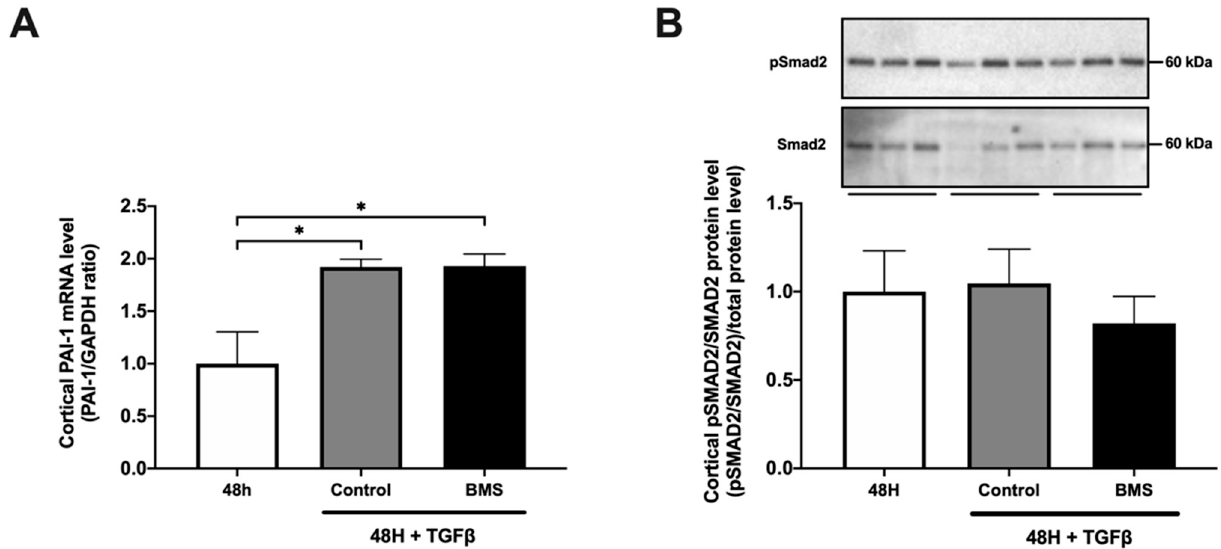
Figure 2. BMS-986205 does not alter canonical TGF- β signaling in murine PCKS. PCKS were exposed to 10 ng/mL TGF- β in the absence or presence of BMS-986205 (5 nM) for 48 h. ( A ) Relative mRNA expression of plasminogen activator inhibitor-1 (PAI-1) normalized to GAPDH. n = 3–7. ( B ) Western blotting was used to study the protein expression of total and phosphorylated Smad2. n = 6. Data are presented as mean ± SEM. * p < 0.05.